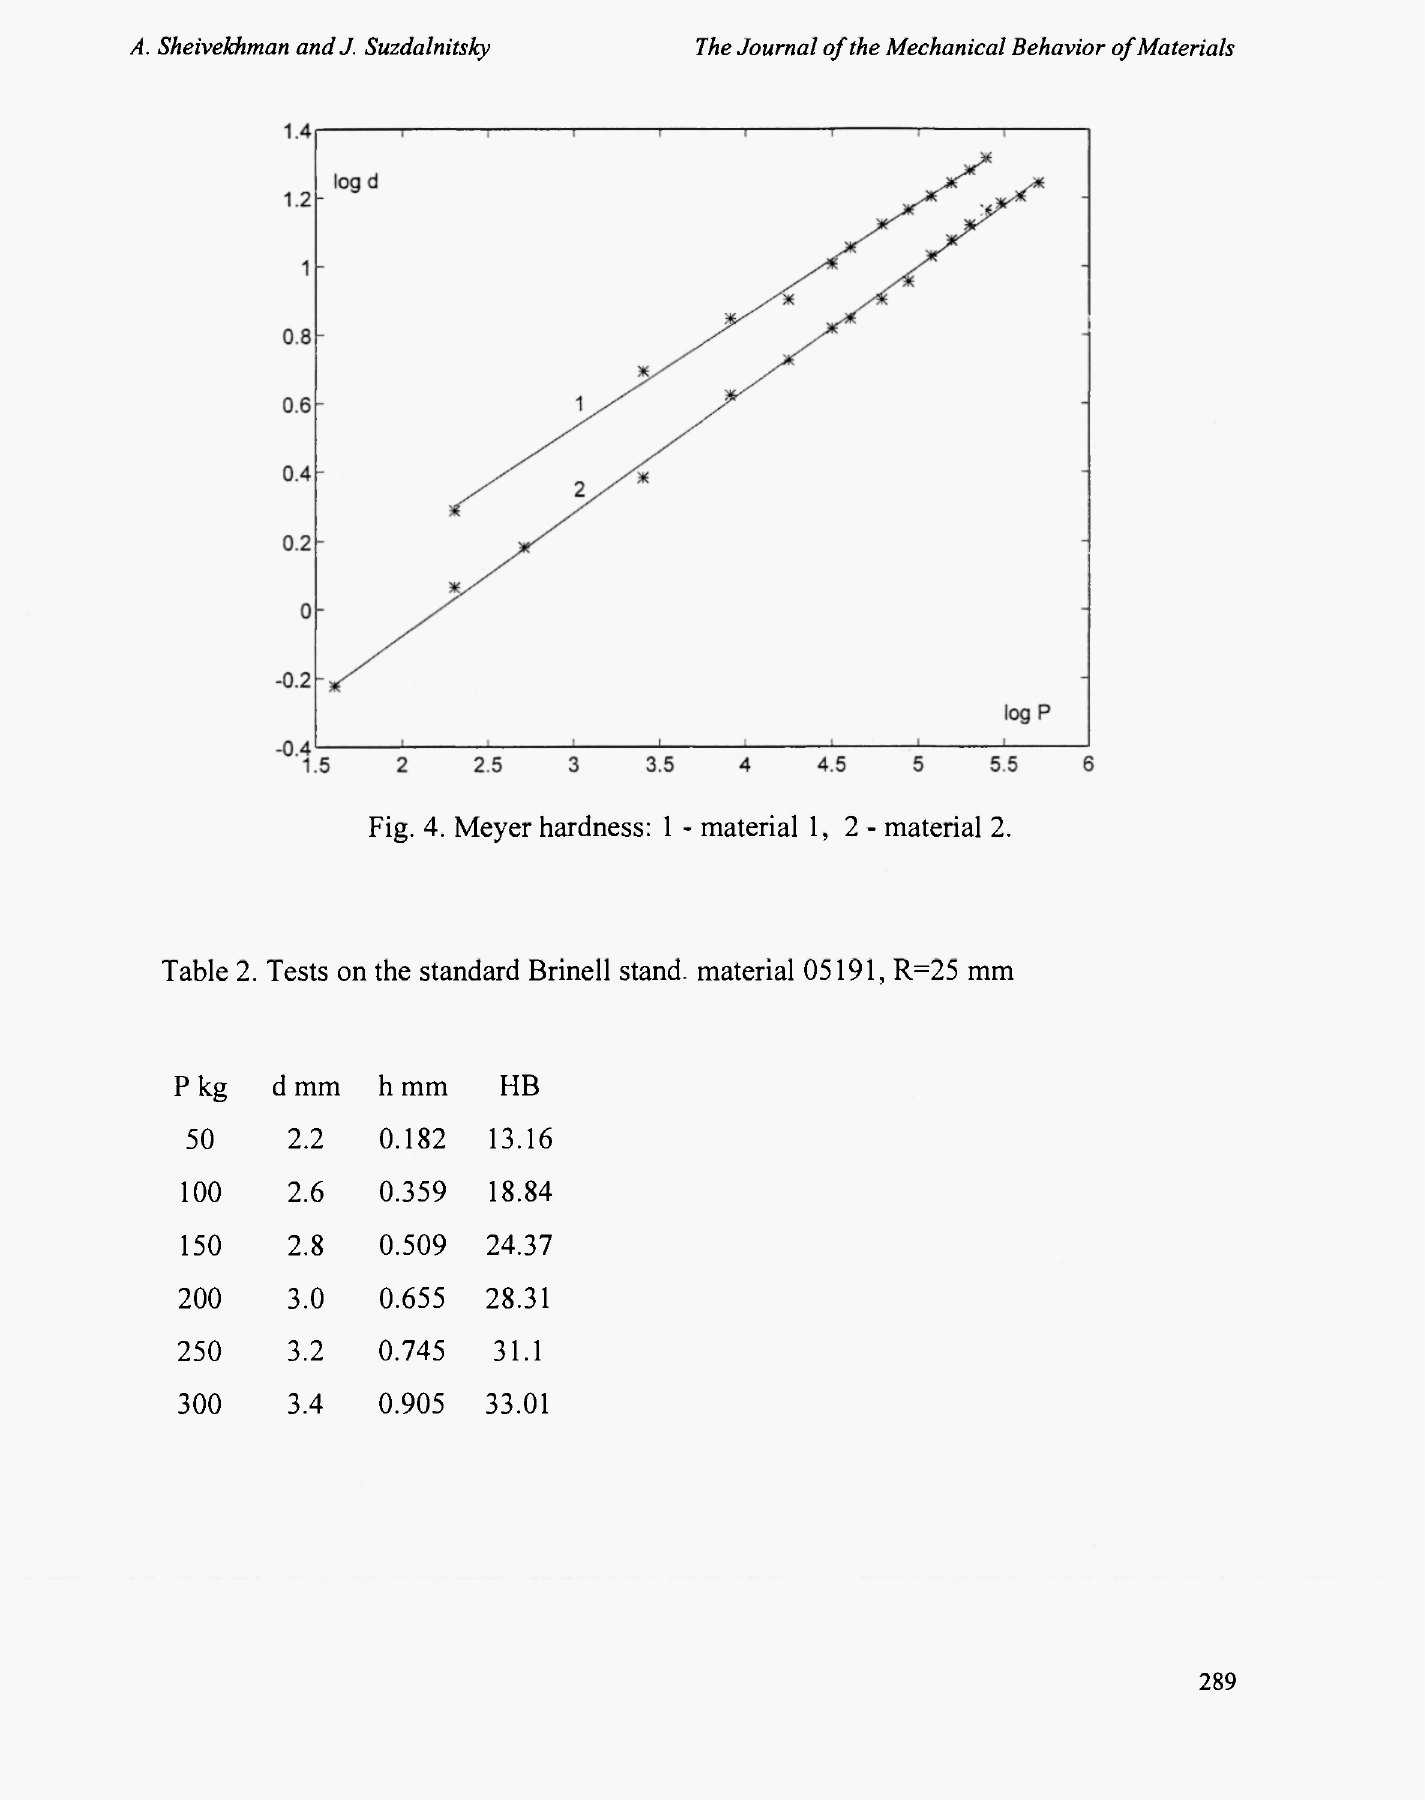
Fig. 4. Meyer hardness: 1 - material 1 , 2- material 2.